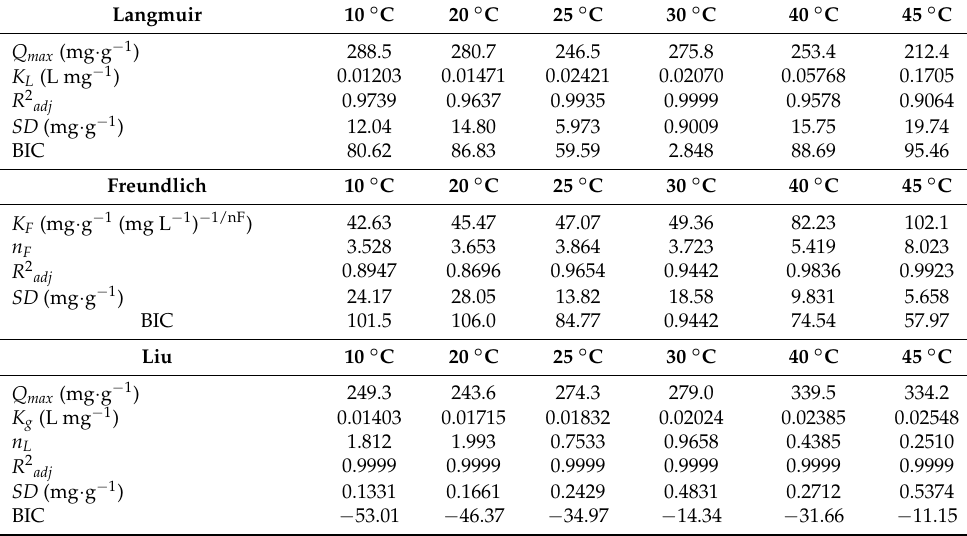
Figure 6. ( a ) Isotherm of adsorption of catechol at 40 ◦ C; ( b ) nonlinear van’t Hoff plot for the calculation of the thermodynamic parameters. Table 4. Equilibrium parameters for the adsorption of catechol onto ABC material. Conditions: m 30 mg; pH 7.0; contact time of 30 min.